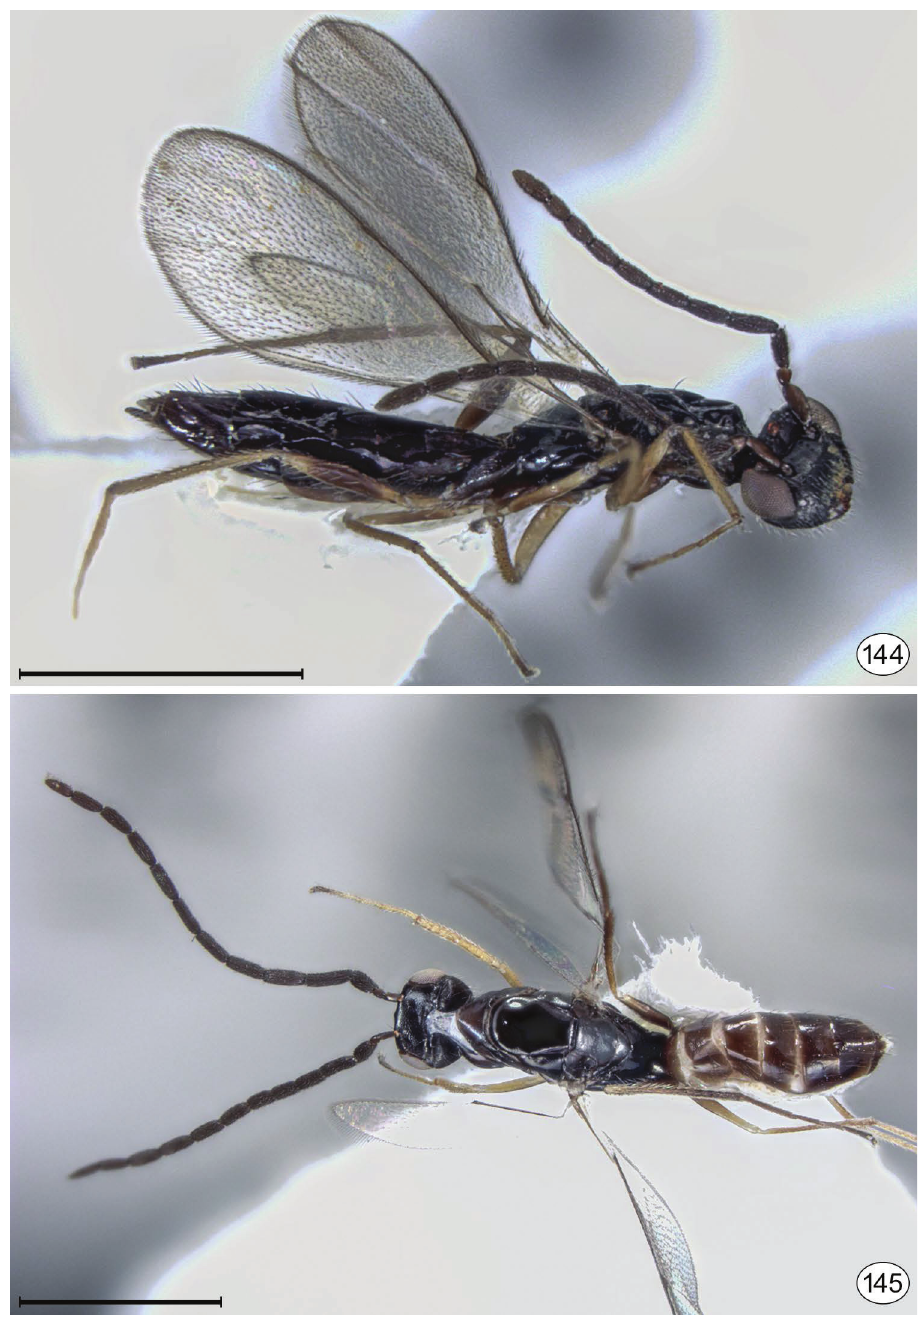
Figures 144, 145. Neotriadomerus sp. 1 (Australia, ACT, 3 km E. Piccadilly Circus, Blundells Creek, 35.22°S, 148.50°E, 850m, xii.1984. 144 female habitus, dorsolateral 145 male habitus, dorsal. Scale bar = 1000